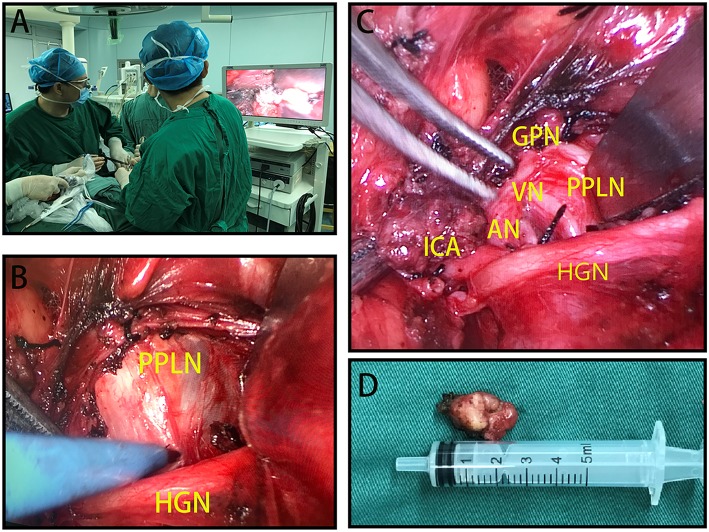
(A) Positions of the surgical team when performing minimally invasive video-assisted (MIVA) parapharyngeal space lymph node (PPLN) resection. (B) PPLNs located interior to the hypoglossal nerve (HGN). (C) PPLNs can be removed, and surrounding structures are carefully exposed and preserved. (D) Resected PPLN specimen. HGN, hypoglossal nerve; ICA, internal carotid artery; AN, accessory nerve; VN, vagus nerve; GPN, glossopharyngeal nerve; PPLN, parapharyngeal space lymph nodes.